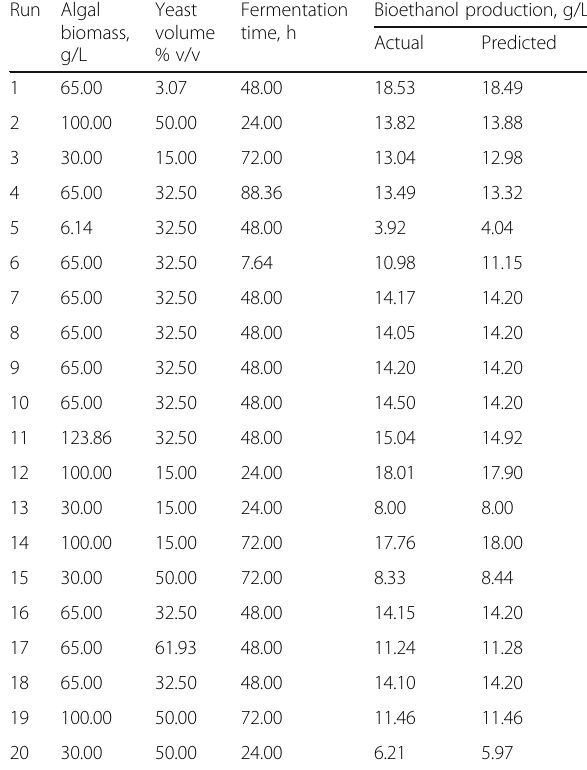
Table 1 Experimental data for central composite